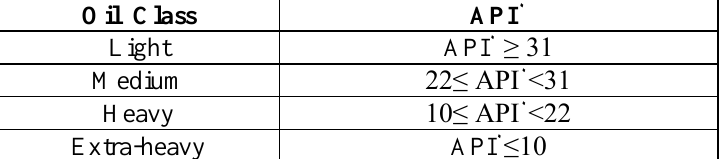
Table 1: Crude oil ordering by the National Petroleum Agency of Brazil (Adapted from ANP, 2000)